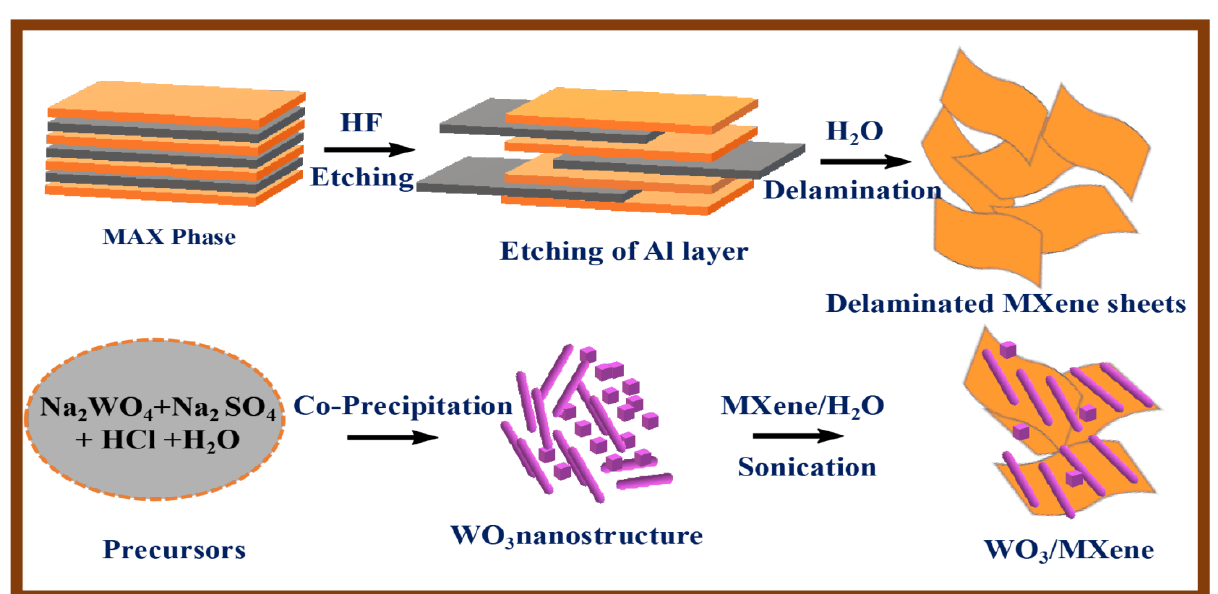
Figure 2. Schematic illustration summarizing synthesis of MXene, WO 3 , and WO 3 /MXene nanocomposite.